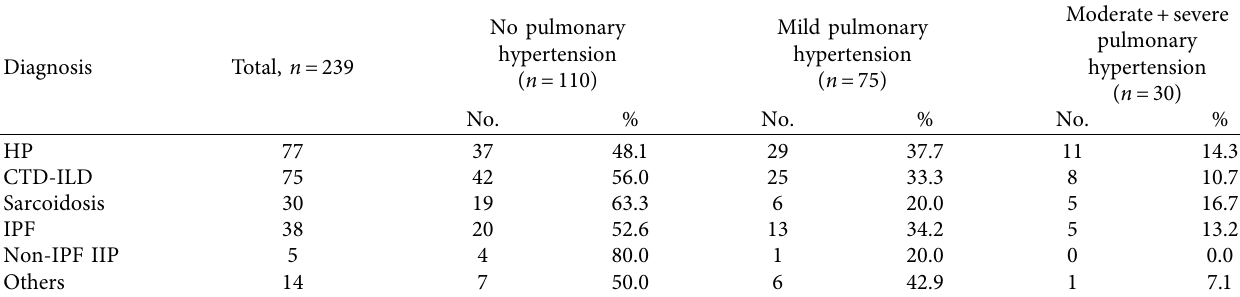
Non-IPF IIP Others